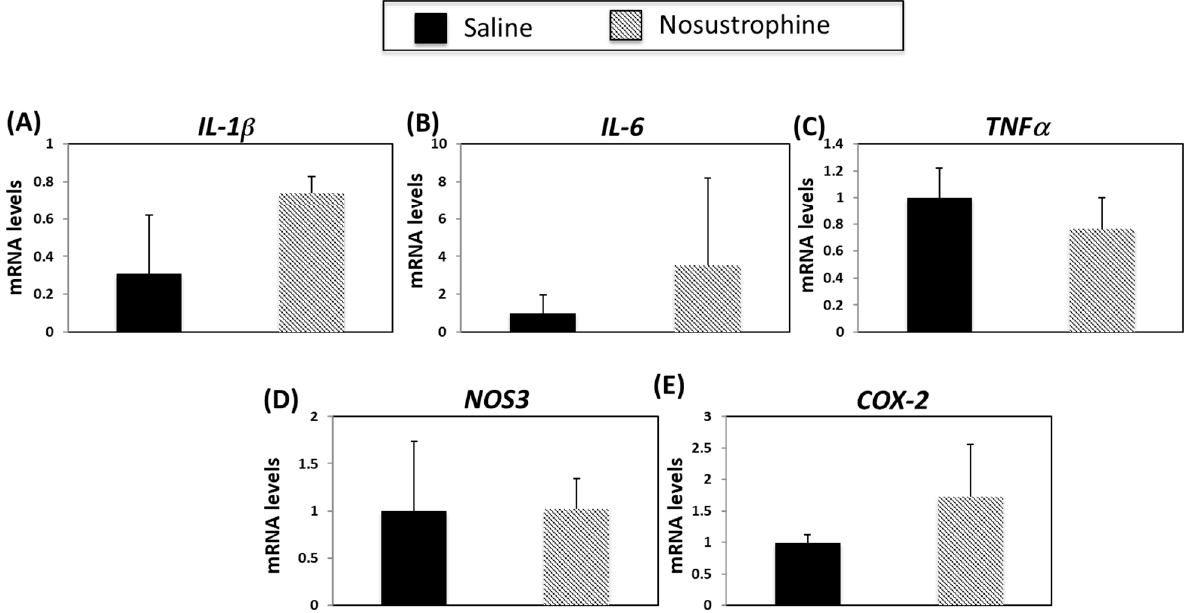
Figure 7. Nosustrophine regulates inflammation-related gene expression in older (8–9-month-old) trigenic AD mice. IL-1 β ( A ), Il-6 ( B ), TNFa ( C ), NOS3 ( D ) and COX-2 ( E ) mRNA levels were measured by qPCR in hippocampus from 3xTg-AD mice ( n = 4 animals per group). Results are expressed as fold induction vs. saline-treated wild-type- or trigenic mice. Data are expressed as means ±